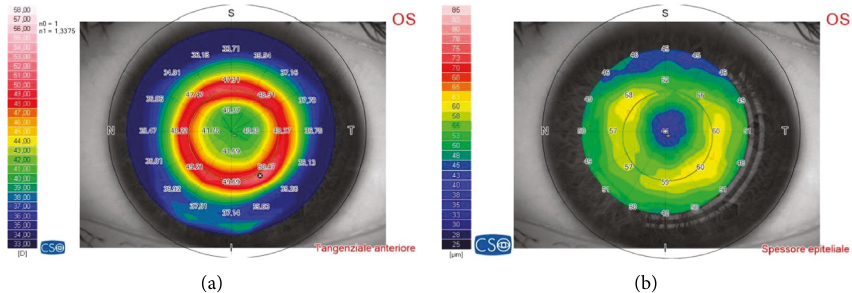
Figure 4: Epithelium remodeling is achieved with orthokeratology. Central corneal flattening is accompanied by a midperipheral steepening (tangential map, (a)), due to accumulation of the epithelium (epithelial thickness map,